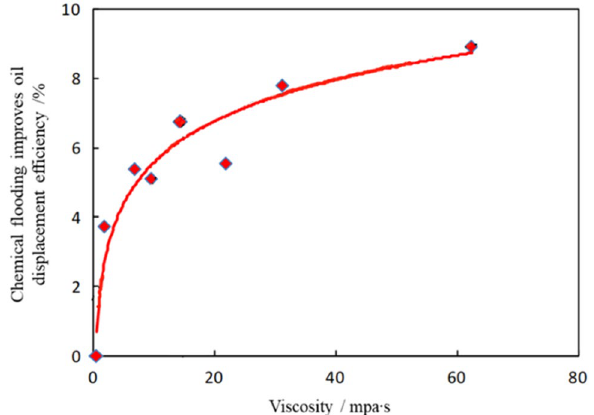
Fig. 12 Oil recovery improvement in polymer